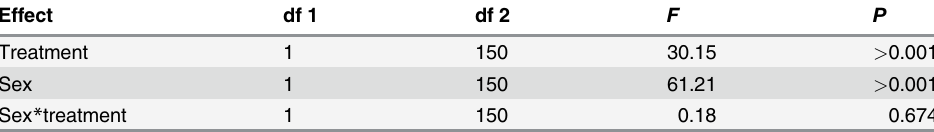
Table 4. Factorial ANOVA results of comparison of larval stage duration between females and males reared on Betula pendula leaves with low and high concentrations of surface lipophilic compounds.